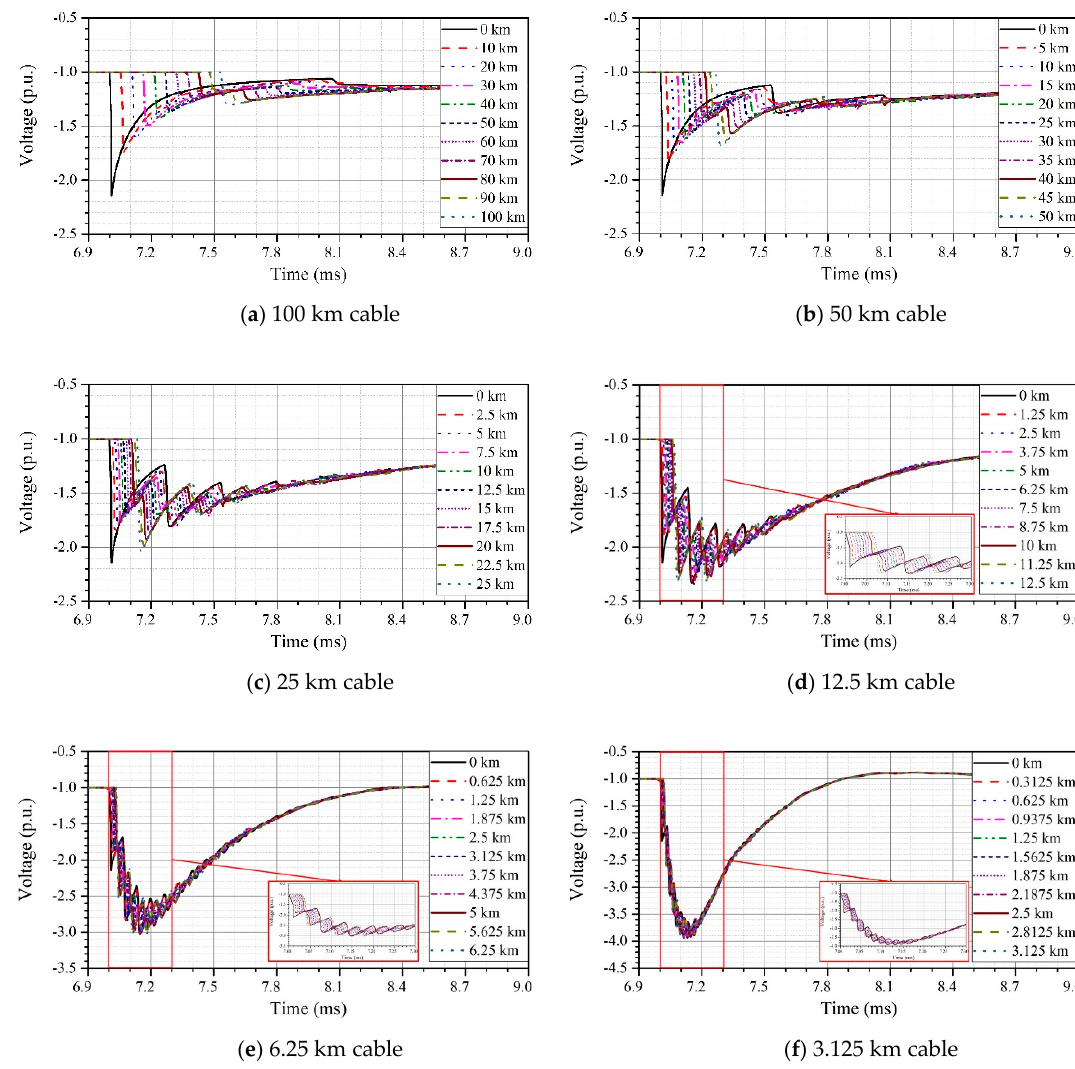
Figure 10. Core-ground overvoltage at ten equally spaced intervals along the length of the cable (3.125–100 km).